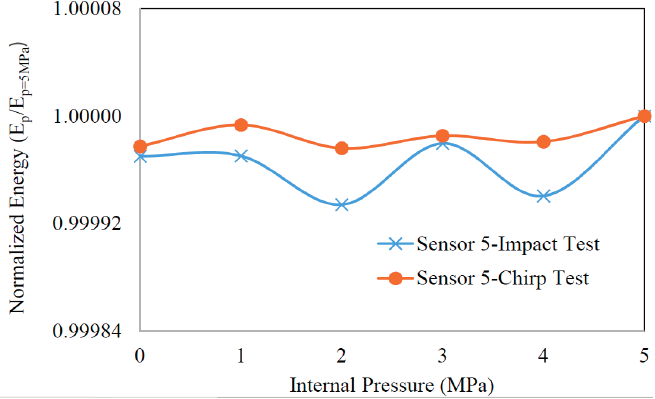
Figure 12. The normalized energy of the vibration signal as a function of internal